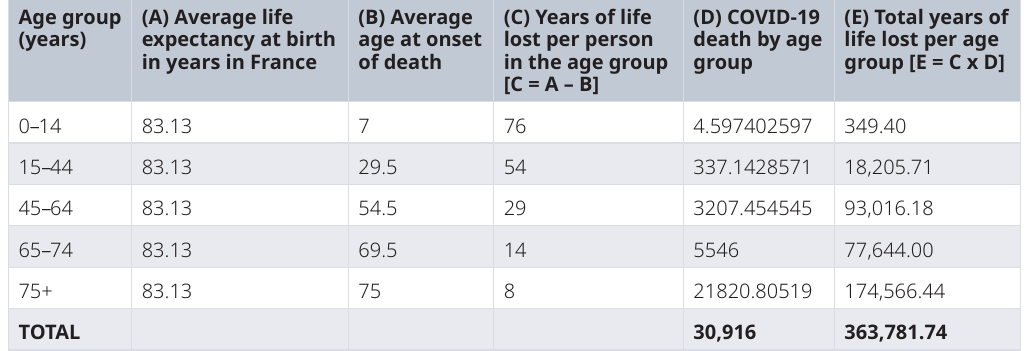
Table 4. Undiscounted years of life lost per person due to COVID-19 in France by 14 September 2020. Age group